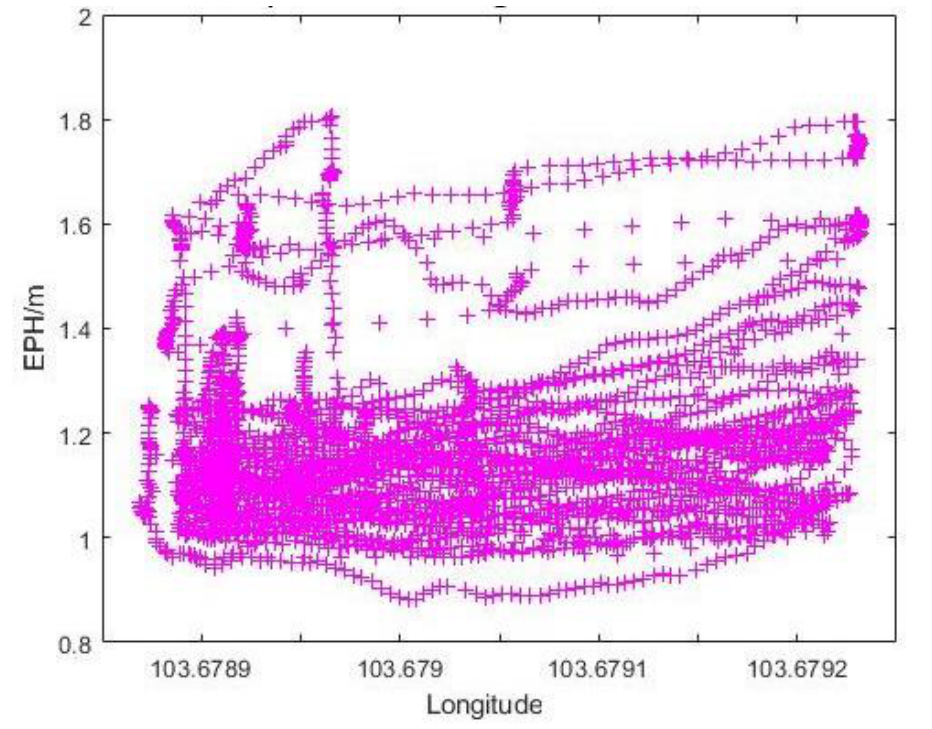
Figure 18. Plot of Measured Horizontal Error vs. Sky Ratio at N3.1.